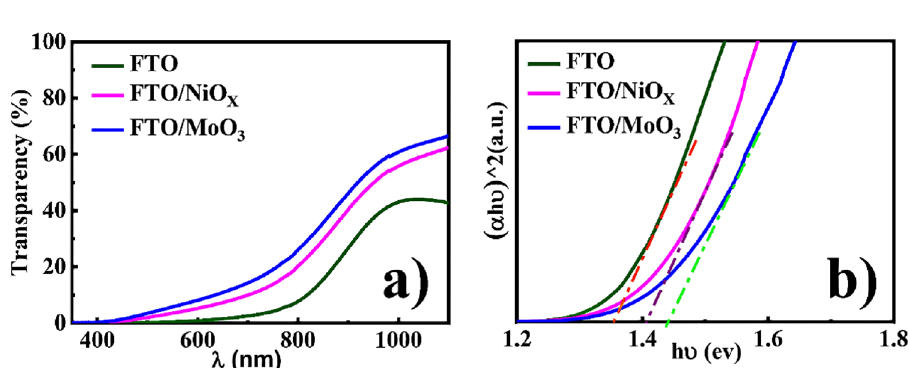
Figure 5. ( a ) Optical transmittance spectra, ( b ) direct band gap (eV) of CISe films deposited on different substrates measured by UV–Vis analysis.